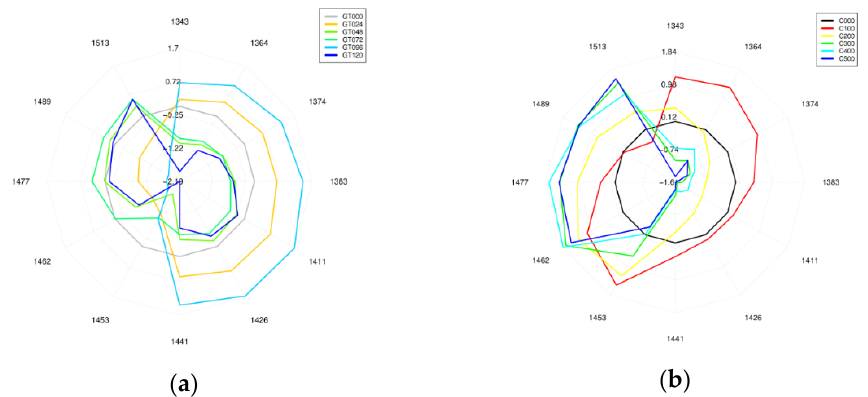
Figure 7. Aquagram plot in the wavelength interval of 1300–1600 nm, after Savitzky-Golay smoothing (SG) and standard normal variate (SNV) pretreatment of the spectra: ( a ) Aquagram plot of germinated mung bean sprout with 24 h intervals, and ( b ) aquagram plot of ascorbic acid with different concentrations.